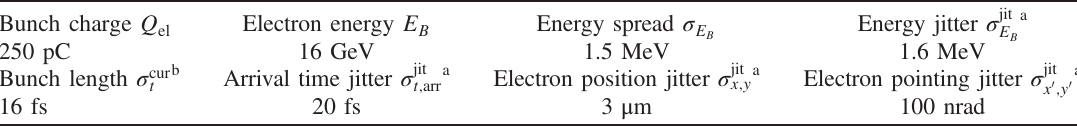
TABLE I. Electron beam parameters (statistical) used for simulation.